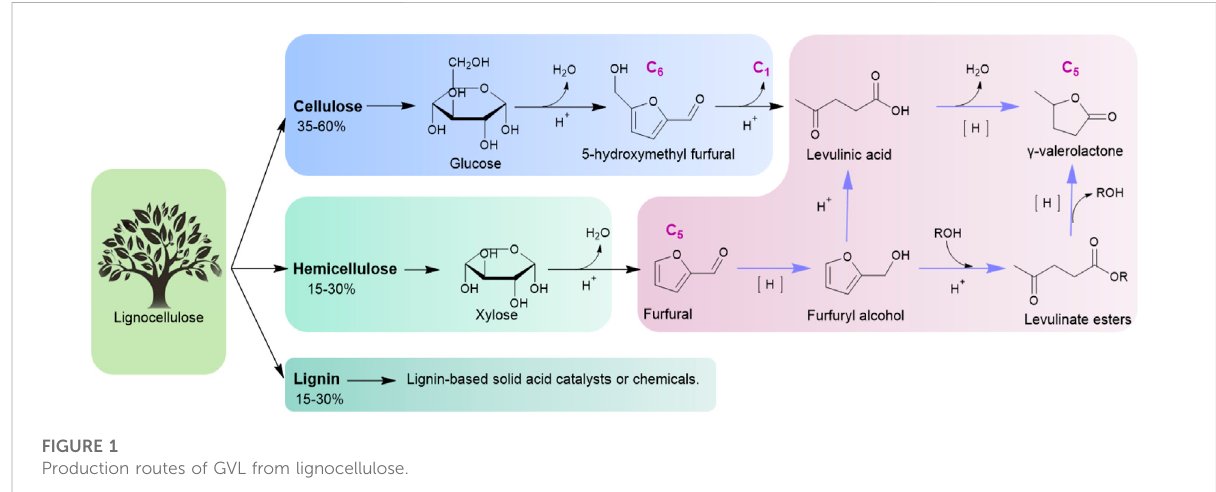
FIGURE 1 Production routes of GVL from lignocellulose.